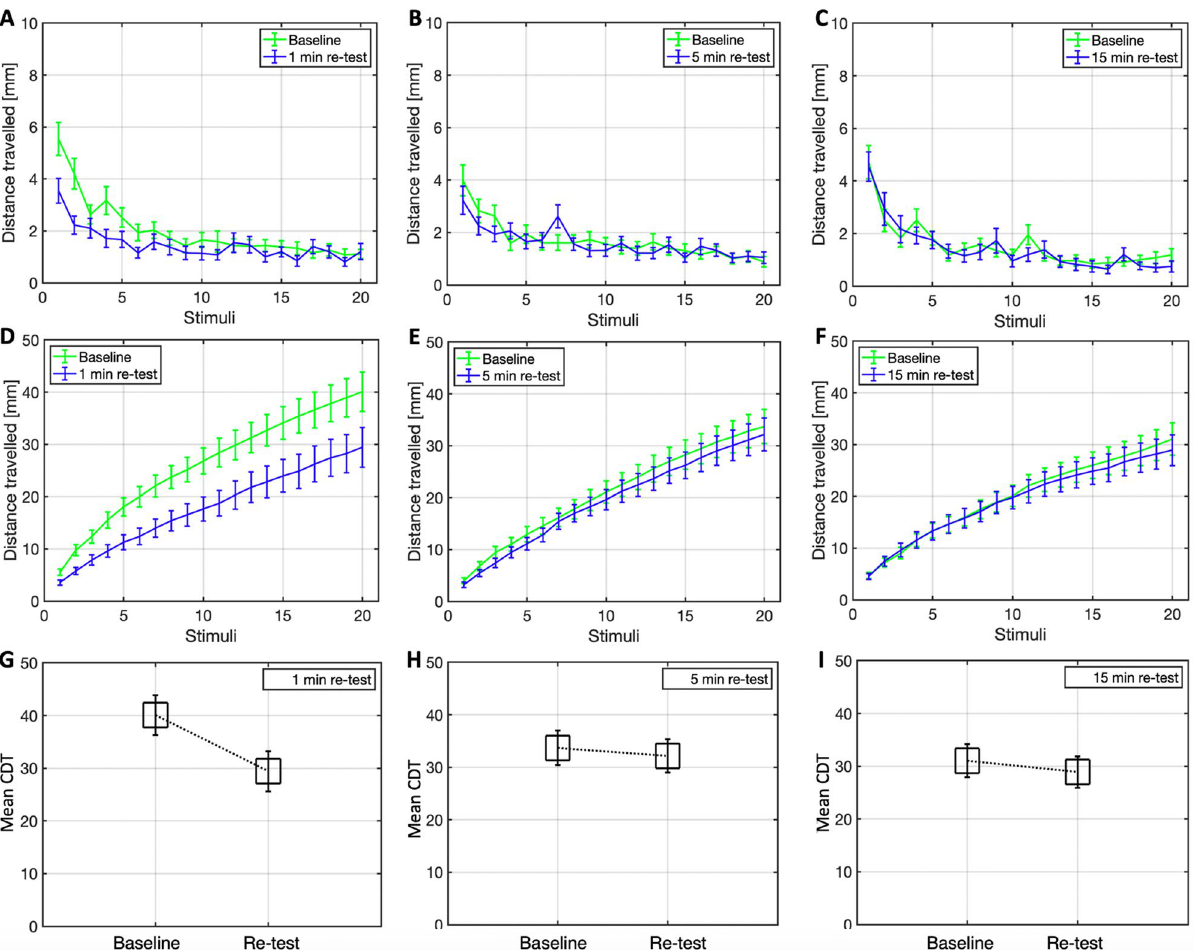
Figure 1. Plots of the distance travelled (M ± 1 SE) at each stimulus, and cumulatively over successive stimuli at baseline and re-test, for the 1 min ( A , D ), 5 min ( B , E ) and 15 min ( C , F ) re-test groups. Boxplots for the CDT (M ± 1 SE) between the baseline and re-test conditions of the 1 min ( G ), 5 min ( H ) and 15 min ( I ) re-test group.